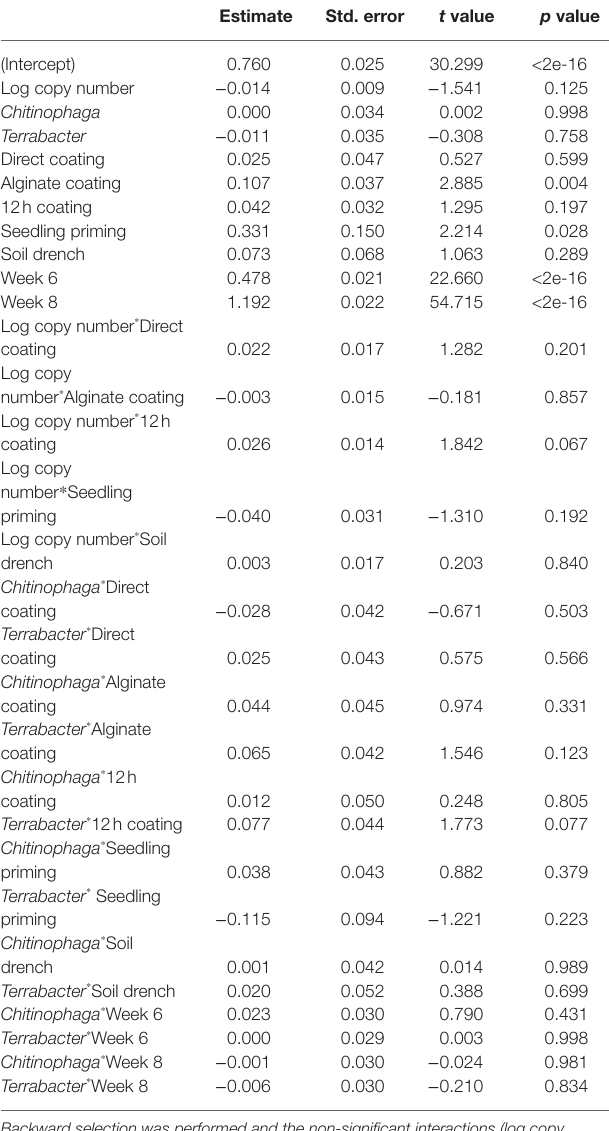
TABLE 4 | Linear model testing the effect of the degree of colonization (log copy number), bacterial strain, inoculation method, and their interactions on sorghum shoot dry